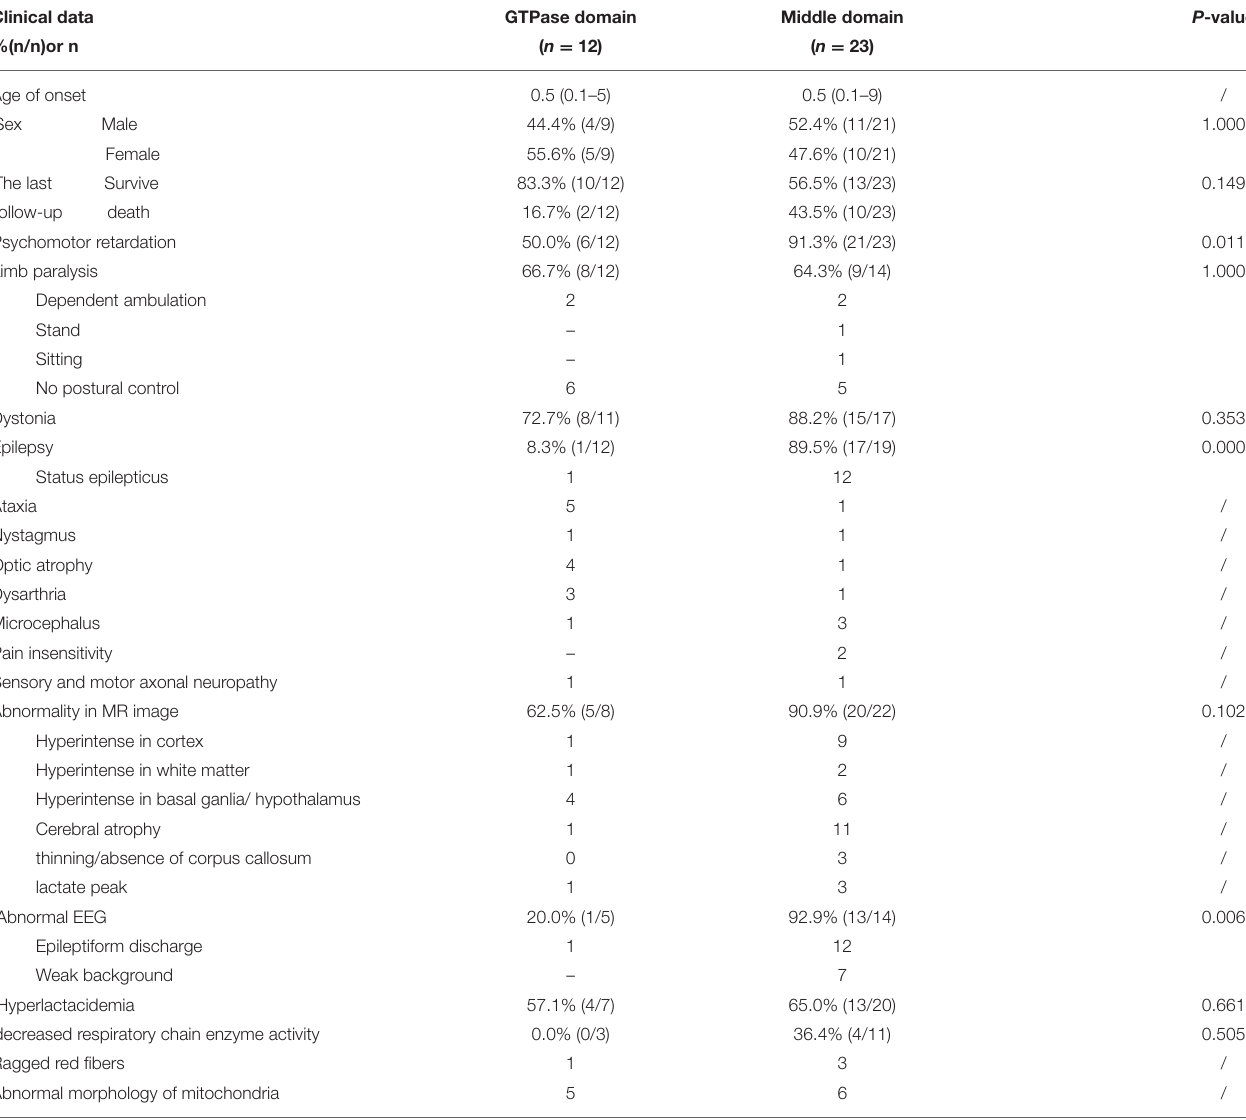
TABLE 3 | The clinical characteristics in patients with DNM1L variants in different domains. Clinical data